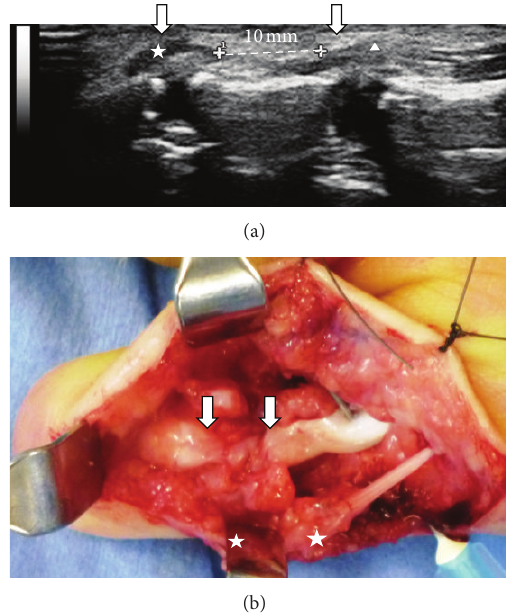
Figure 1: (a) Preoperative finding of the ultrasonography: the discontinuity of the FPL and both ends of the ruptured FPL tendon were shown. The asterisk showed the distal lacerated FPL tendon, and the triangle showed the proximal lacerated FPL tendon. The gap was calculated approximately 10mm. (b) Operative findings: the primary suture was possible for the lacerated FPL tendon (arrows) and for the radial digital nerve (asterisks).